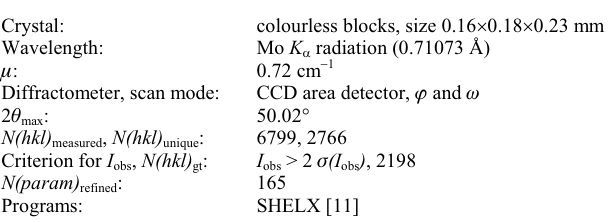
Table 1. Data collection and